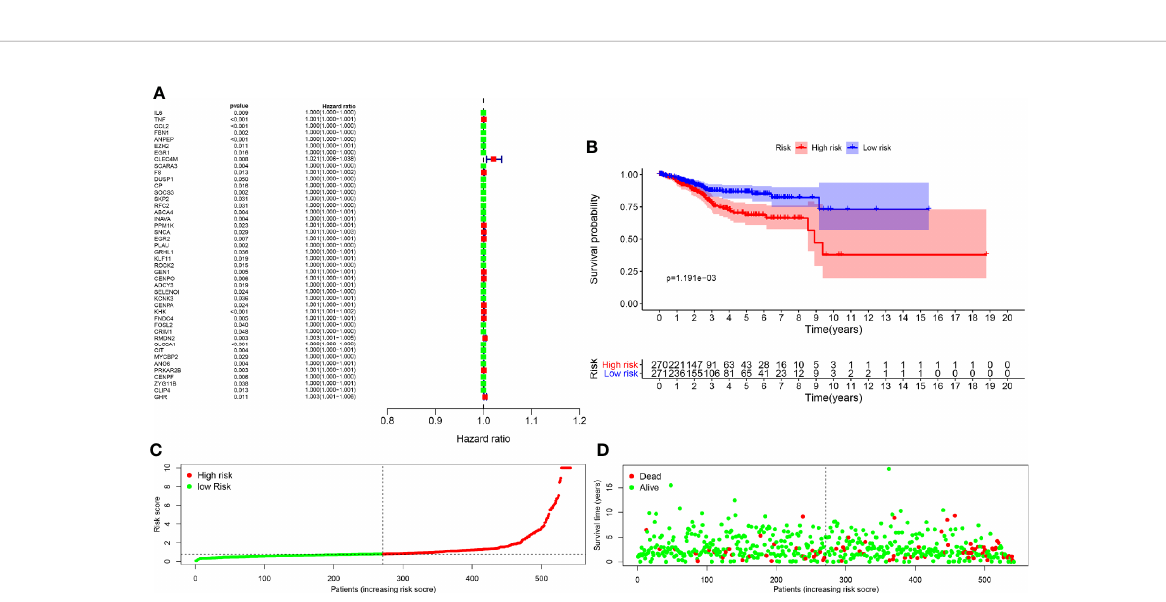
FIGURE 2 | Clinical features of UCEC/COVID-19-related genes. (A) , Univariate Cox determination was conducted to identify 44 candidate genes. (B) , Multivariate Cox analysis identi fi ed 13 speci fi c genes, including CCL2, ANPEP, CLEC4M, SCARA3, CP, ABCA4, KHK, SLC8A1, ZYG11B, GHR, TNF, FOSL2, and PLAU. The survival analysis suggested statistical signi fi cance associated with 13 speci fi c genes in the overall survival between high- and low-risk groups. (C, D) , Further analysis showed the greater the patient ’ s risk value, the higher the patient ’ s risk score; similarly, higher mortality and lower